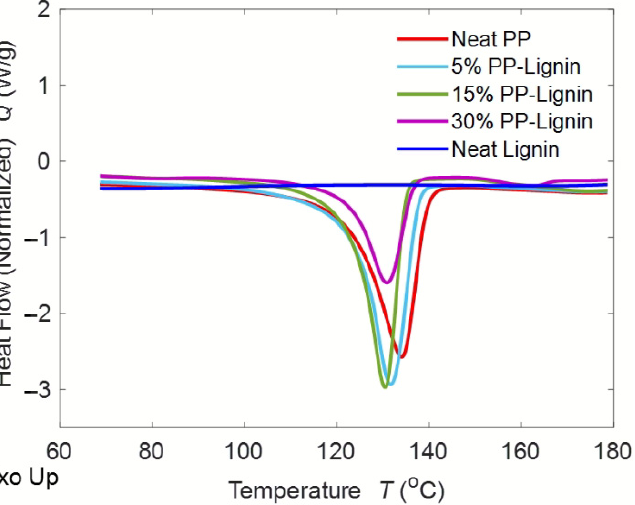
Figure 3. DSC Traces of PP/Lignin Blends.